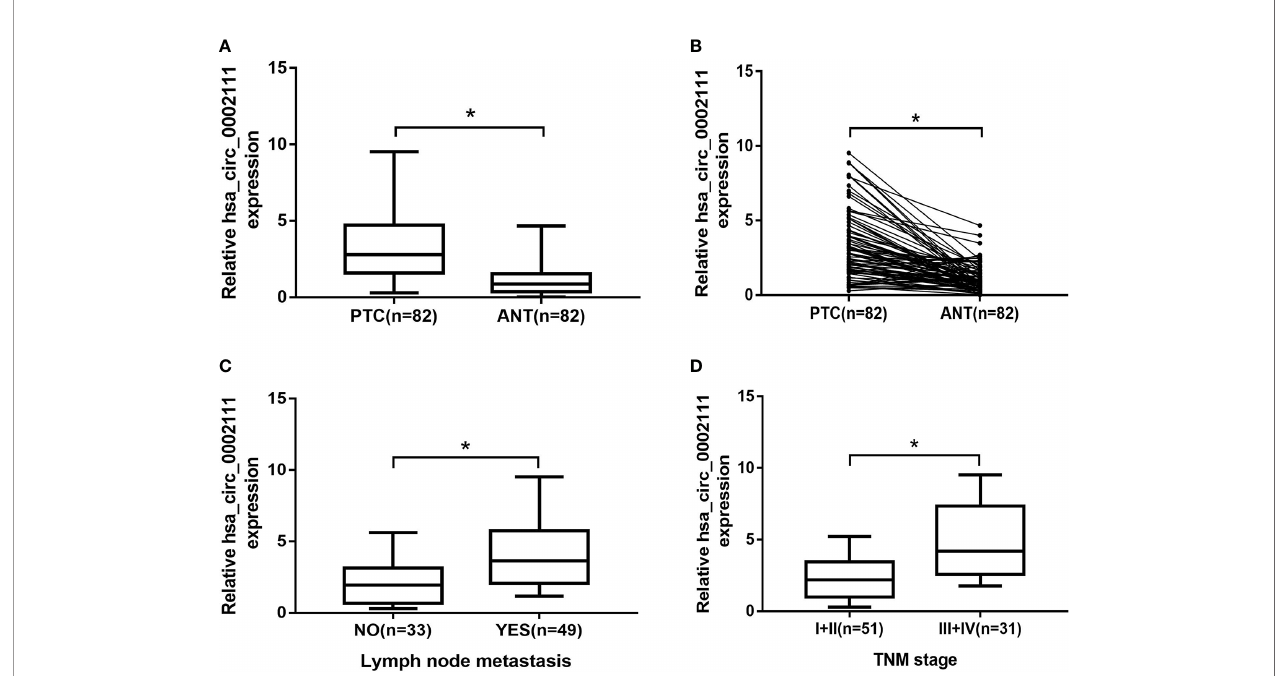
FIGURE 2 | Expression level of hsa_circ_0002111 in papillary thyroid cancer (PTC) tissues and its clinical signi fi cance. (A, B) hsa_circ_0002111 expression was signi fi cantly higher in PTC tissues compared to that in adjacent non-tumor tissues. (C) hsa_circ_0002111 expression was higher in PTC patients with lymph-node metastasis. (D) hsa_circ_0002111 expression was higher in PTC patients with III + IV stage compared to that in patients with I + II stage. *P < 0.05.